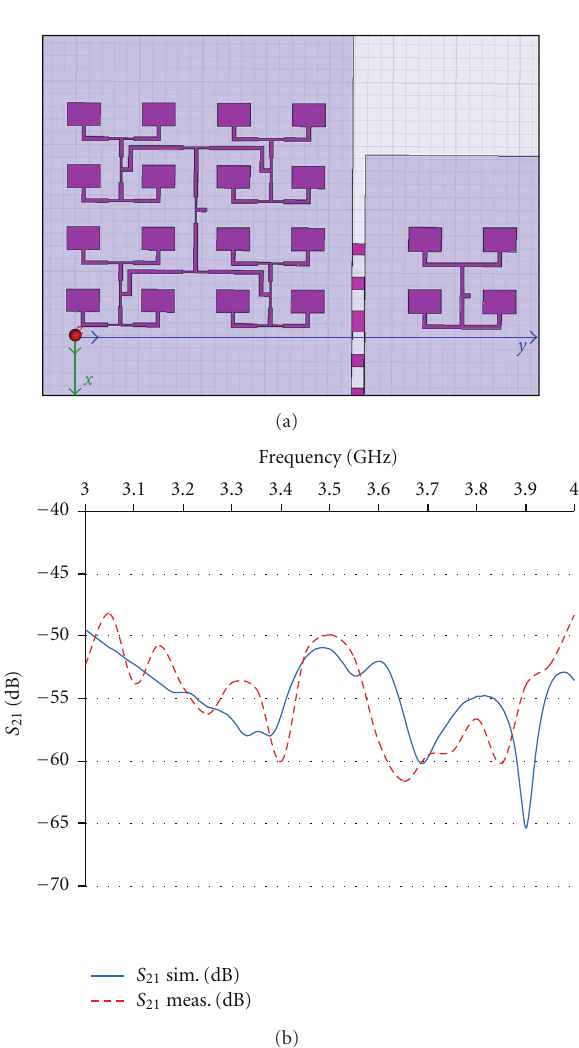
Figure 16: (a) Simulation of access and backhaul antennas for con- figuration 2 ( ω = 180 ◦ ). (b)Simulation and experiment S 21 for ω = 180 ◦